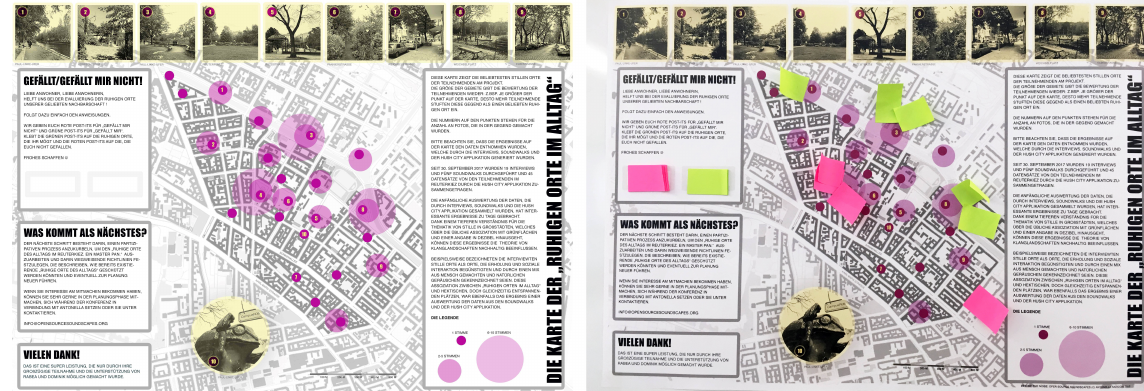
Figure 10: On the left, the "Reuterkiez Everyday Quiet Areas Map”; on the right, the results coming from the interactive game played with